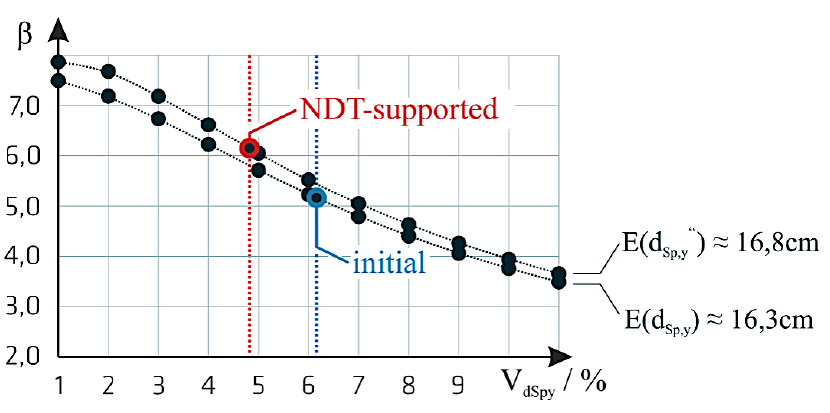
Figure 3. Individual effects of including the non-destructively measured vertical position of the transverse tendons on reliability using FORM in SLS decompression; β HL,init = 5 , 18, β HL,NDT = 6 , 18; d Sp,init ∼ N (16 , 3 cm, 1 , 0 cm ), cf. [8]; d Sp,NTD ∼ N (16 , 8 cm, 0 , 8 cm ); extracted from